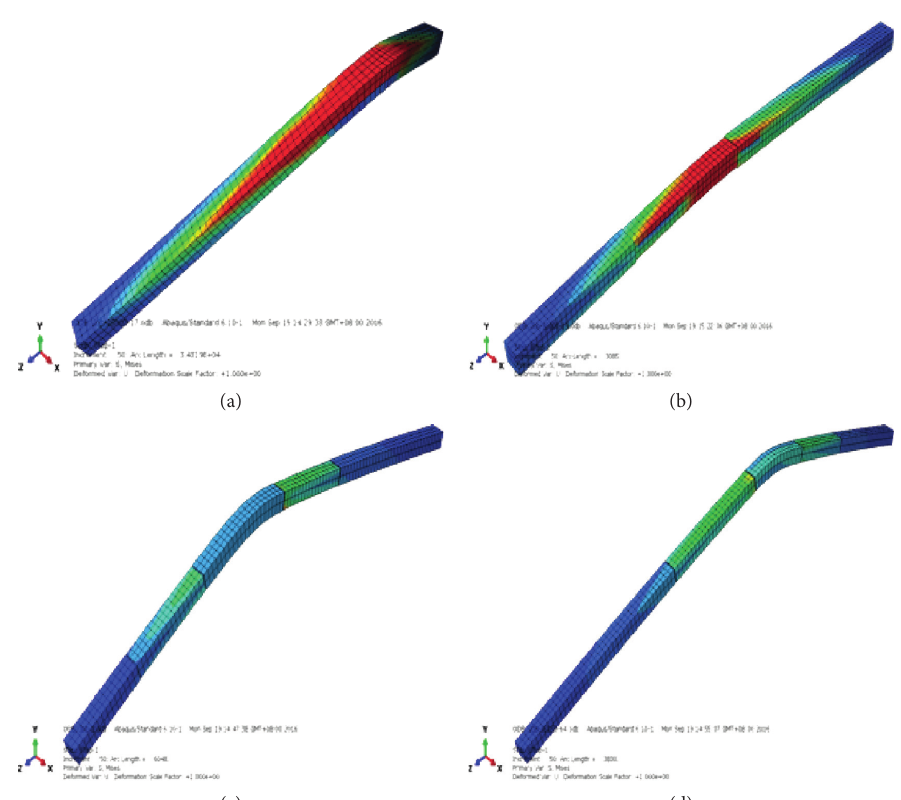
Figure 10: Buckling configuration of representative specimens. (a) JS000-11, (b) JS000-13, (c) JS142-23, and (d)